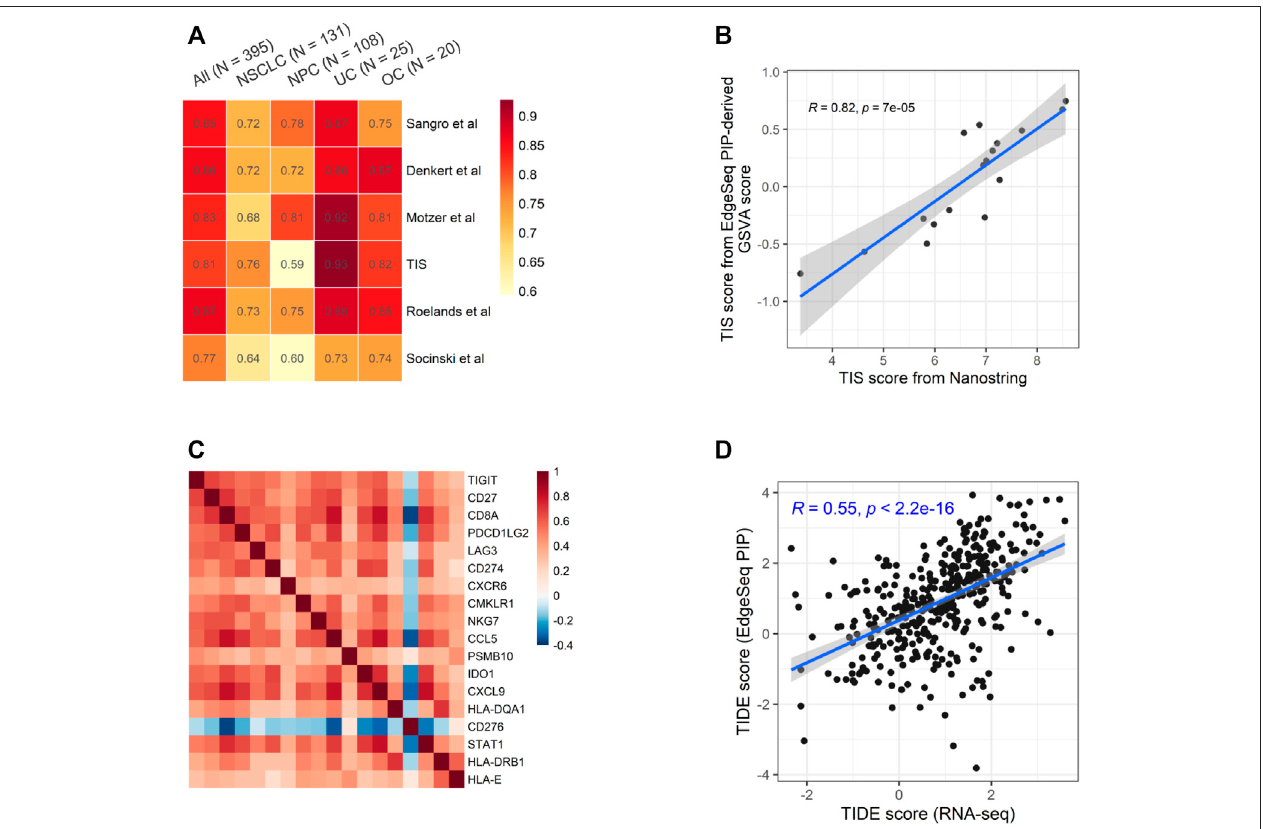
FIGURE3| ConcordanceofEdgeSeqPIPandRNA-seqforpotentialICI-predictivesignatures (A) Heatmapshowingthecorrelationcoef fi cientsofsixICI-predictive signaturesbetweenEdgeSeqandRNA-seq.Columnsrepresenttheoverallcorrelationandcorrelationineachmajorcancertype. (B) Scatterplotshowingthecorrelation of GSVA score derived from EdgeSeq PIP data with the of fi cial TIS scores from NanoString IO360 assay. (C) Heatmap showing the co-correlation of genes within TIS signature using RNA-seq data. (D) Scatter plot showing the correlation of TIDE score calculated from RNA-seq data and EdgeSeq PIP data.